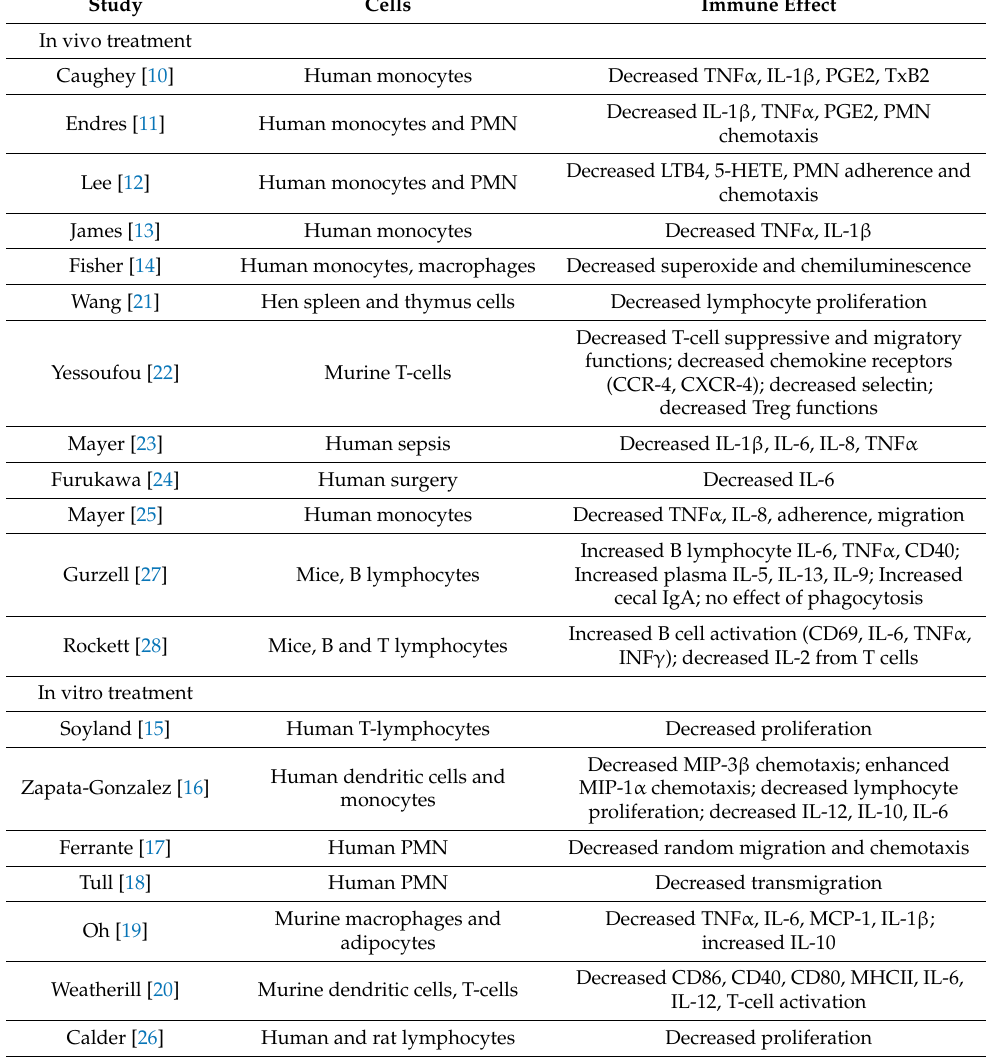
Table 1. Immune Effects of n -3